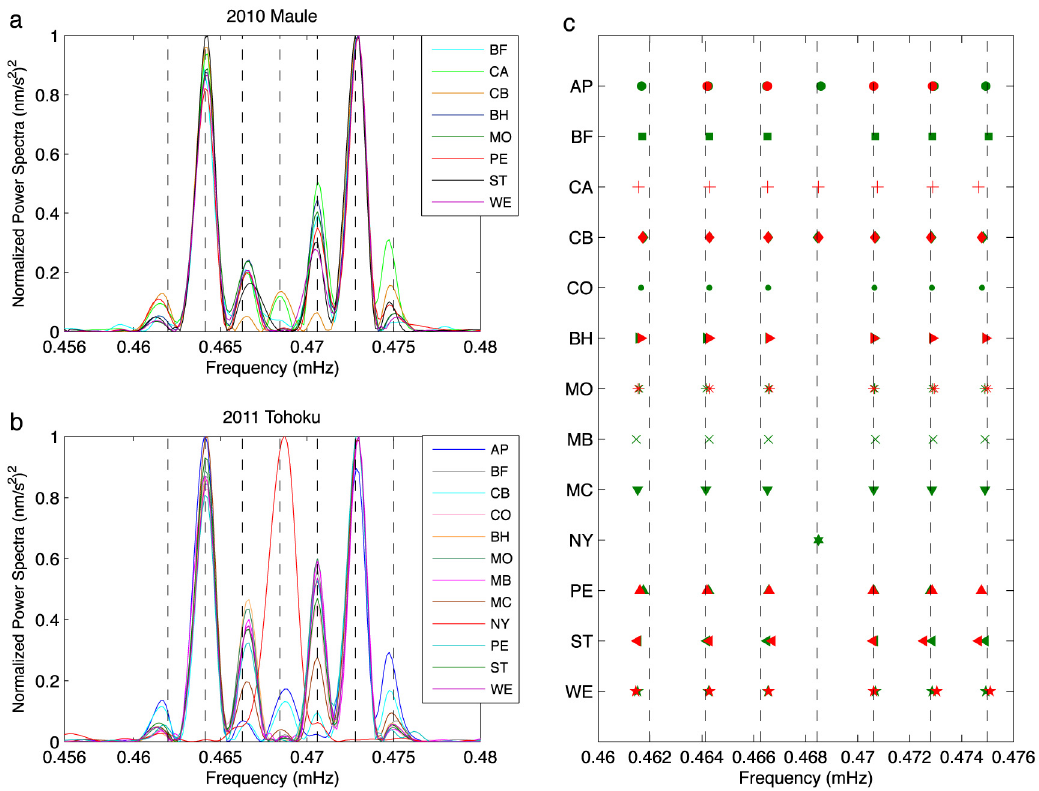
S based on the residual gravity time series after the 2010 and 2011 events. (a) The results of 8 residual grav- Figure 4. The power spectra of 0 3 ity time series after the 2010 Maule event; (b) the results of 12 residual gravity time series after the 2011 Tohoku; (c) the estimated frequen- cies from different series. The PREM predictions (from Rosat et al. [2008]) are denoted by vertical dashed lines.